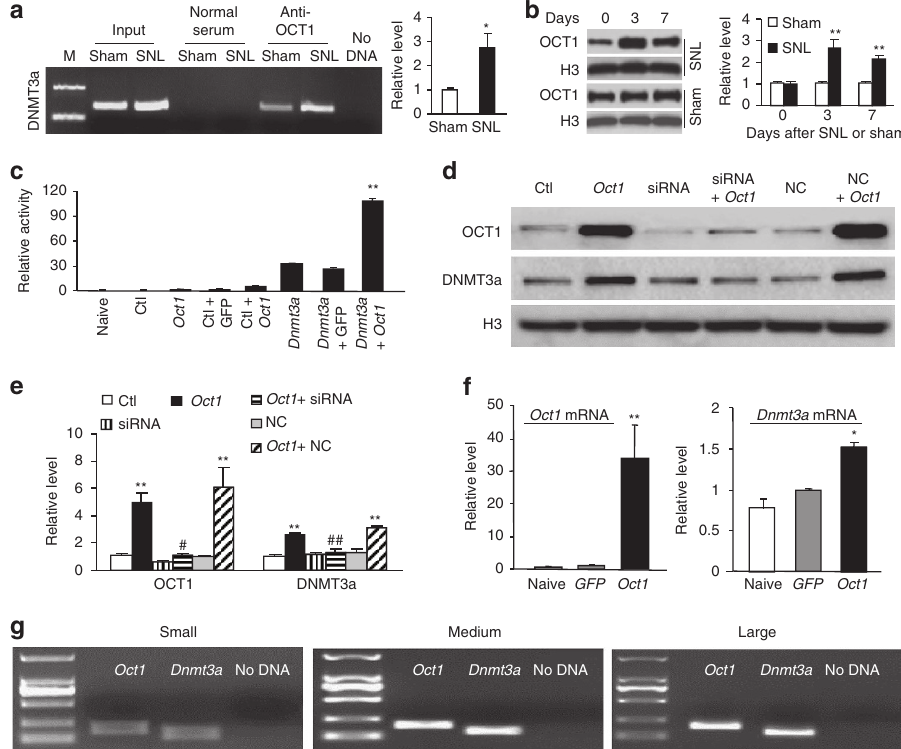
Figure 3 | OCT1-triggered Dnmt3a gene transcription following peripheral nerve injury in rat injured DRG. ( a ) The Dnmt3a promotor fragment immunoprecipitated by rabbit anti-OCT1 antibody in the ipsilateral L5 DRG on day 7 post-SNL or sham surgery. Input, total purified fragments. M, ladder